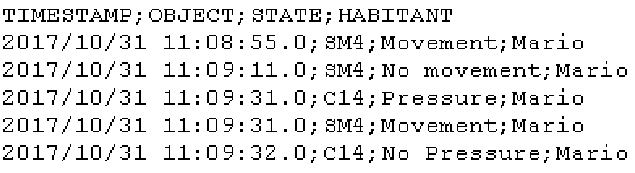
Figure 9. Excerpt from the file